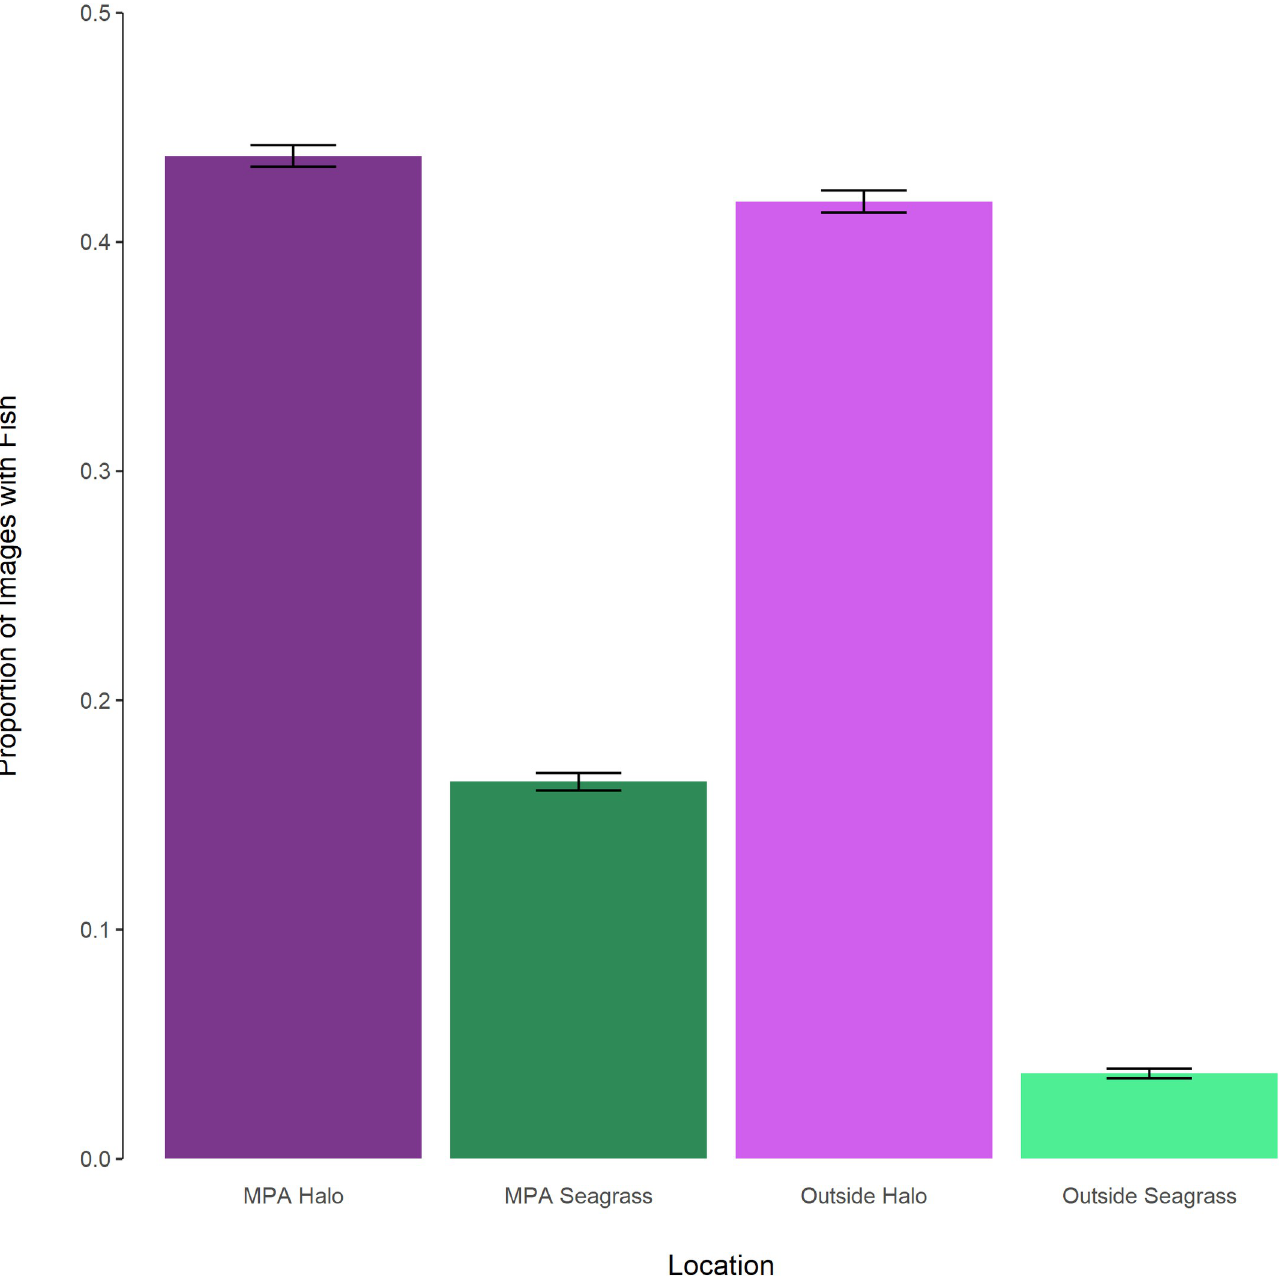
Fig 6. Proportion of images containing fishes at halo and grass/algae sites inside and outside of the Half Moon Caye MPA. Halo sites are represented in shades of purple, seagrass/algae sites in shades of green. Each bar is a proportion based on the n for that treatment. Error bars represent ± 1 standard deviation from the binomial distribution, scaled by the respective n for each